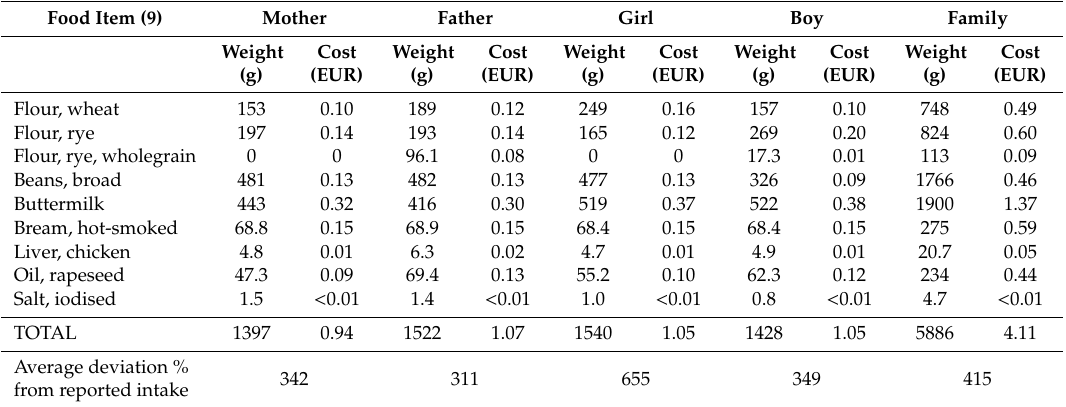
Table 4. Composition of the lowest cost Food Basket (LCFB) fulfilling all recommended nutrient intakes for all members of an Estonian family, including weights and cost of the single